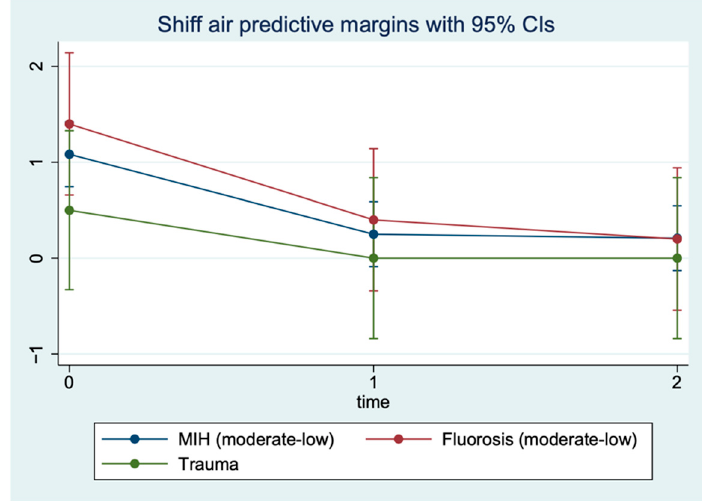
Figure 7. Shiff air index levels predicted by repeated measures (three timepoints) restricted maximum